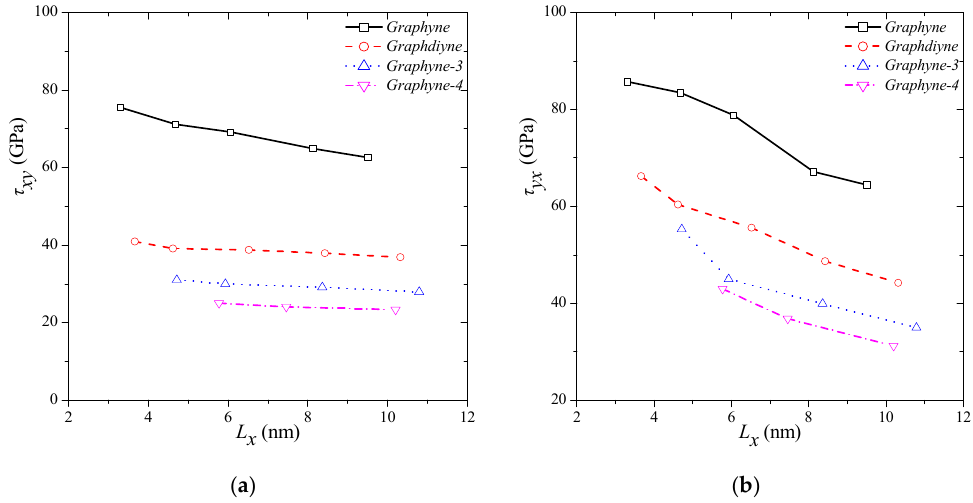
Figure 6. Shear modulus variations in different graphyne structures in ( a ) x–y and ( b ) y–x direction.